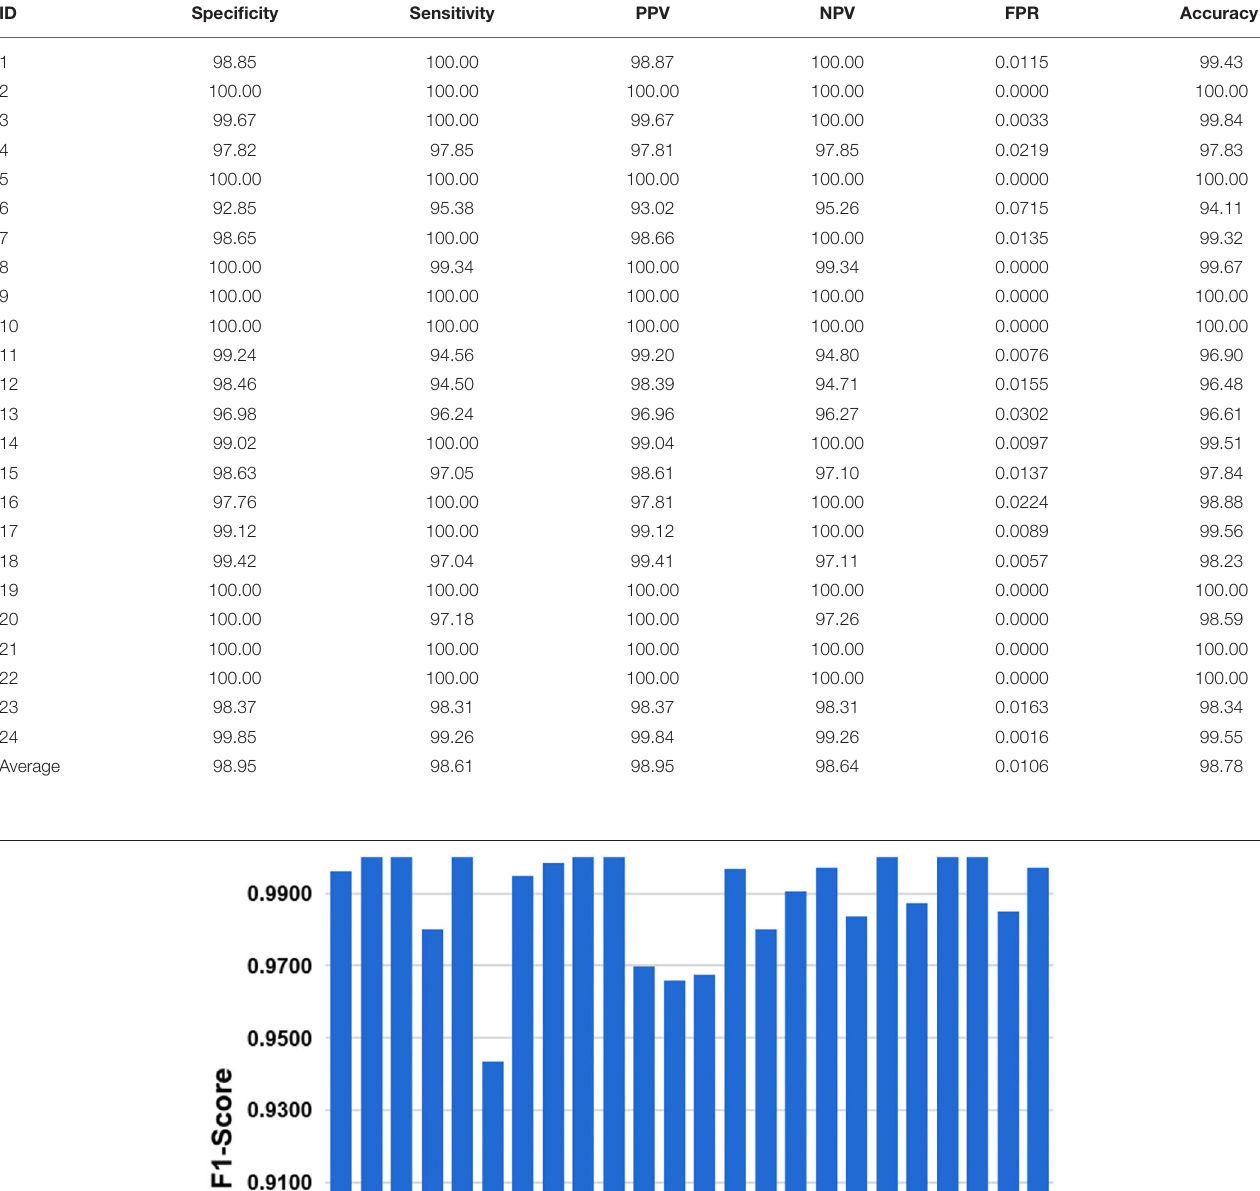
Frontiers in Neuroinformatics |